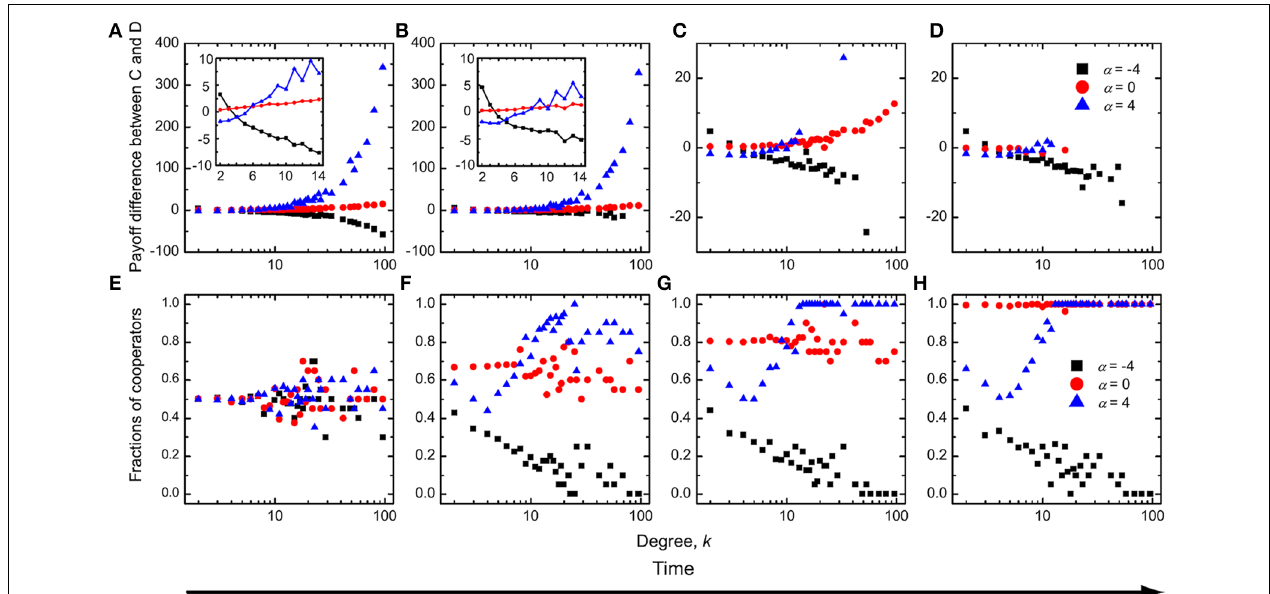
between cooperators and defectors for low-degree and middle-degree nodes during the early stages of evolution. During the evolutionary process, if the